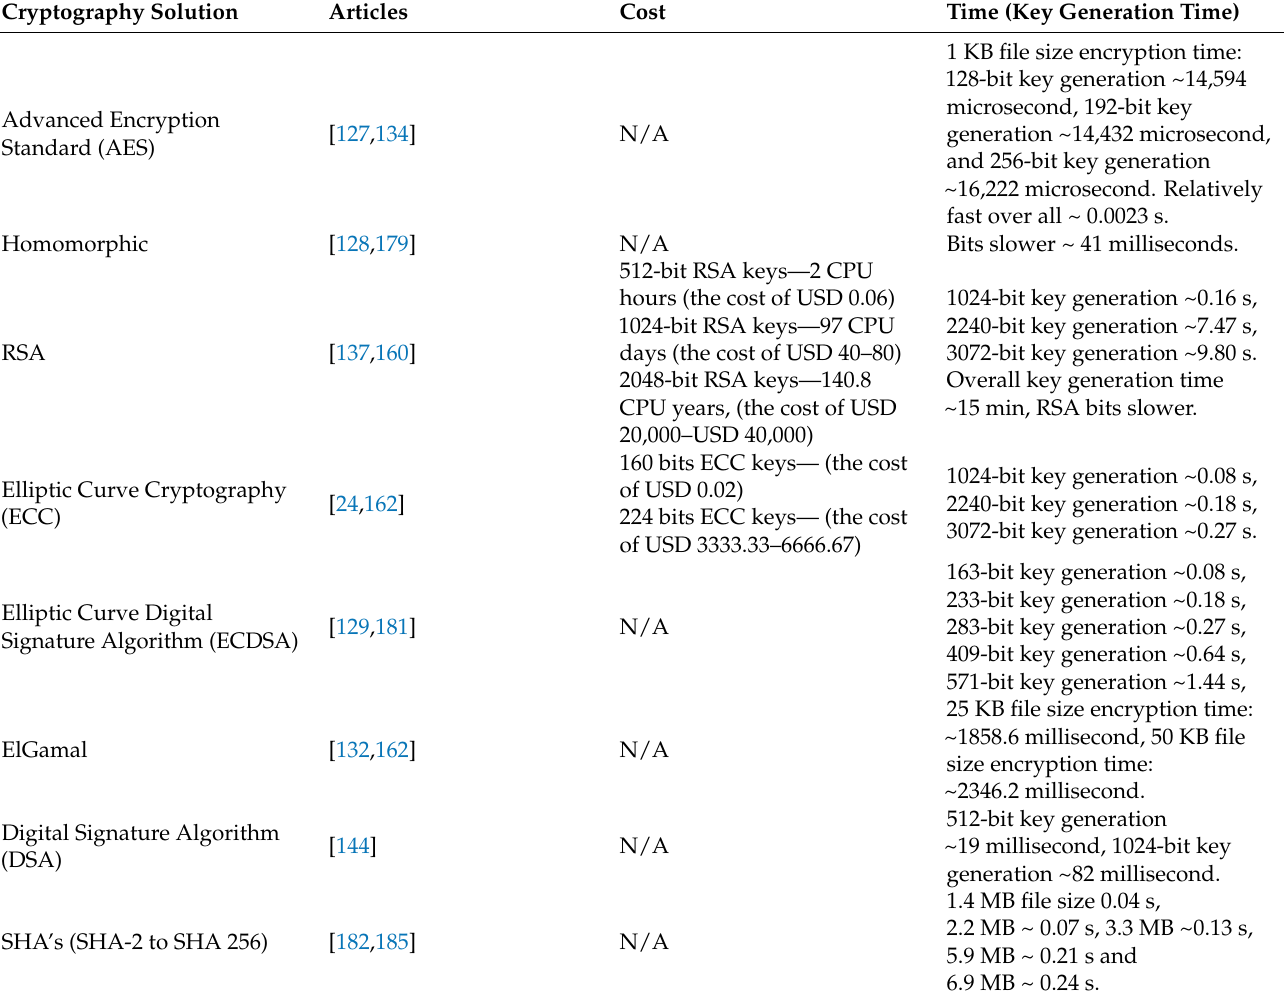
Table 12. Cryptographic